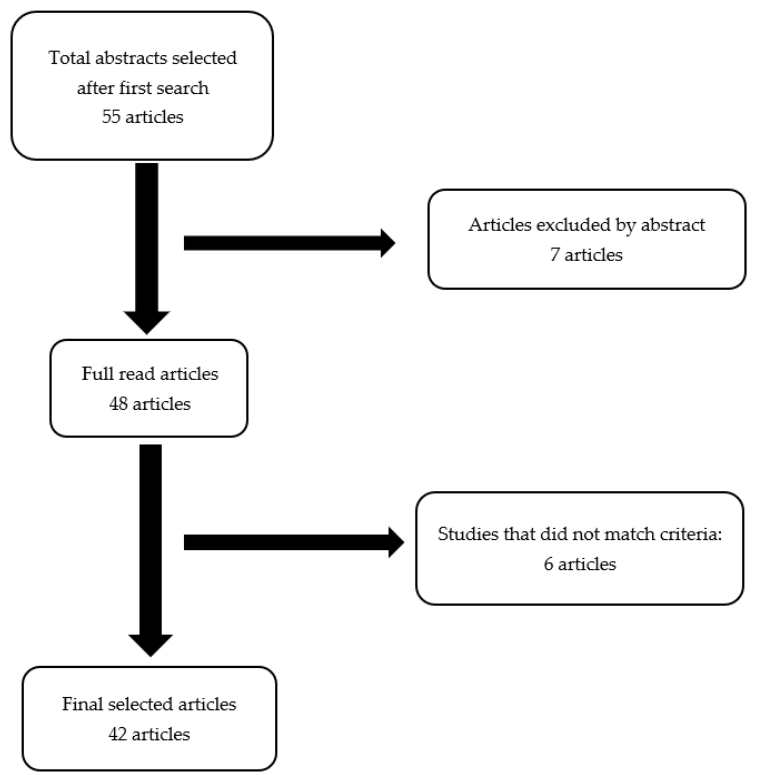
Figure 7. Algorithm of article selection.